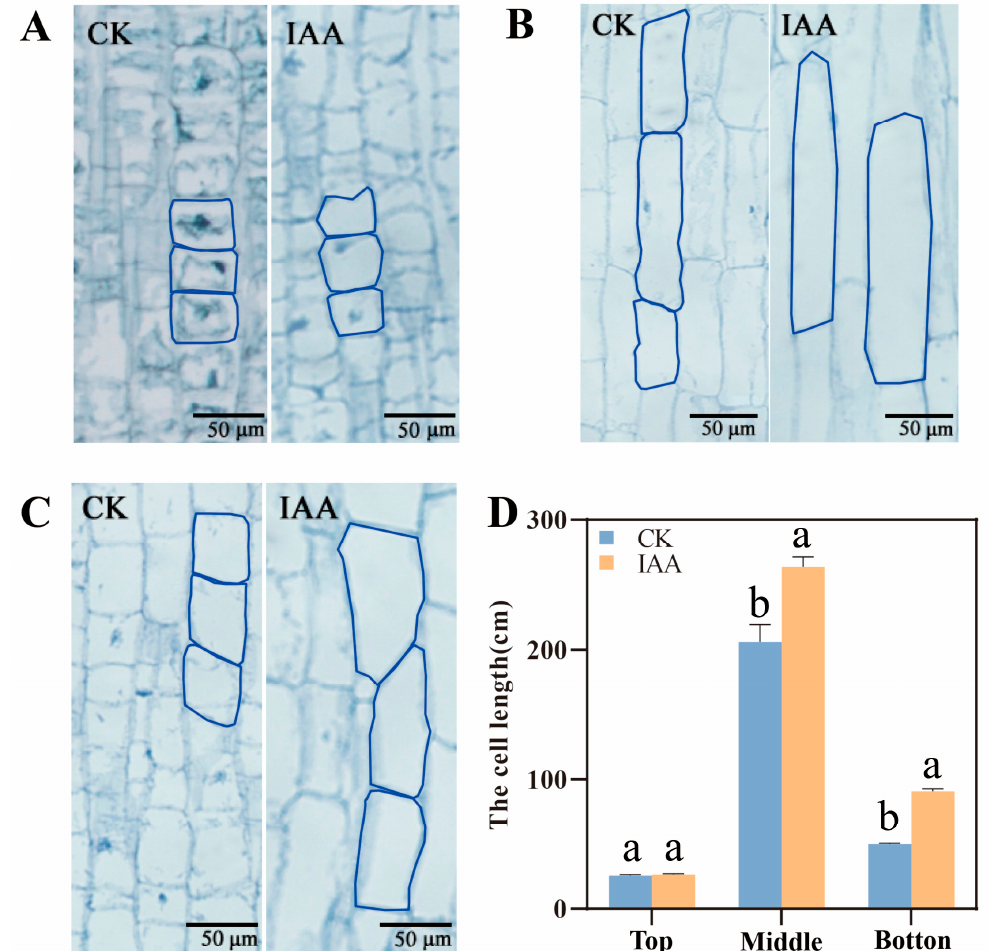
Figure 3. Cell length of different parts of mesocotyl in line MS24B. ( A ) The up part of mesocotyl cell in CK and IAA treatment under the vision of stereomicroscope in MS24B; ( B ) The middle part of mesocotyl cell in CK and IAA treatment under the vision of stereomicroscope in MS24B; ( C ) The down part of mesocotyl cell in CK and IAA treatment under the vision of stereomicroscope in MS24B; ( D ) The cell length statistics of different parts of mesocotyl in MS24B. Lowercase letters indicate statistical differences ( p ≤ 0.05) among treatments.